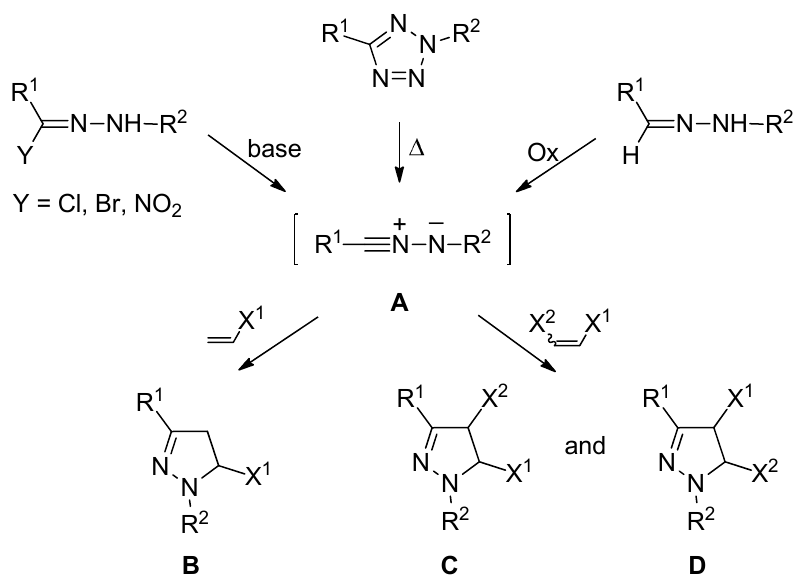
Figure 1. General picture describing the formation of nitrilimine intermediate ( A ) and their regioselectivity towards mono- ( B ) and 1,2-disubstituted ( C , D ) alkenes.